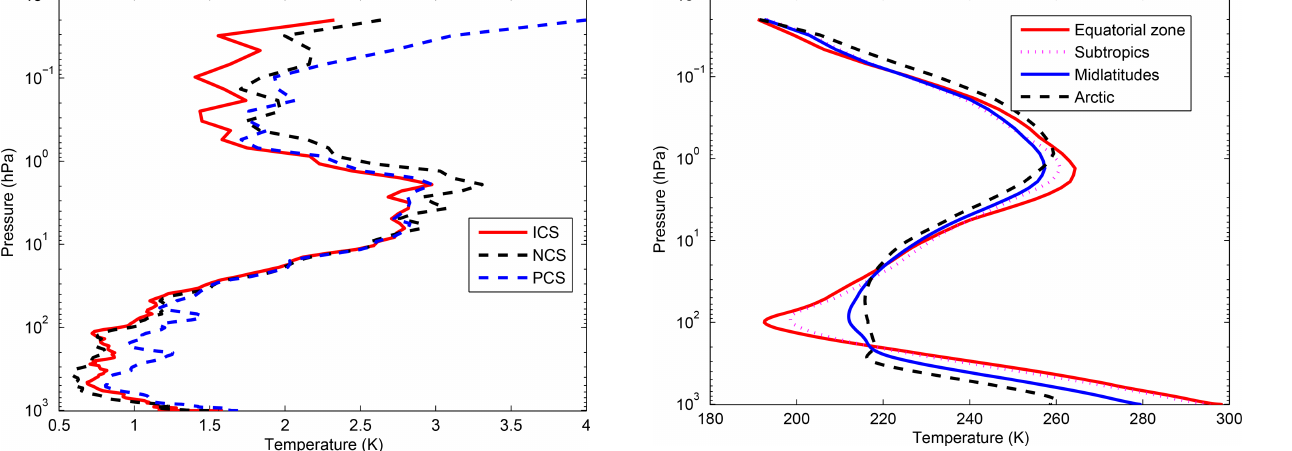
Figure 9. The temperature profile standard deviation of statistical inversion comparison experiments. The red line indicates the result of ICS. The dashed black line stands for the result of NCS. The dashed blue line represents the result of PCS.